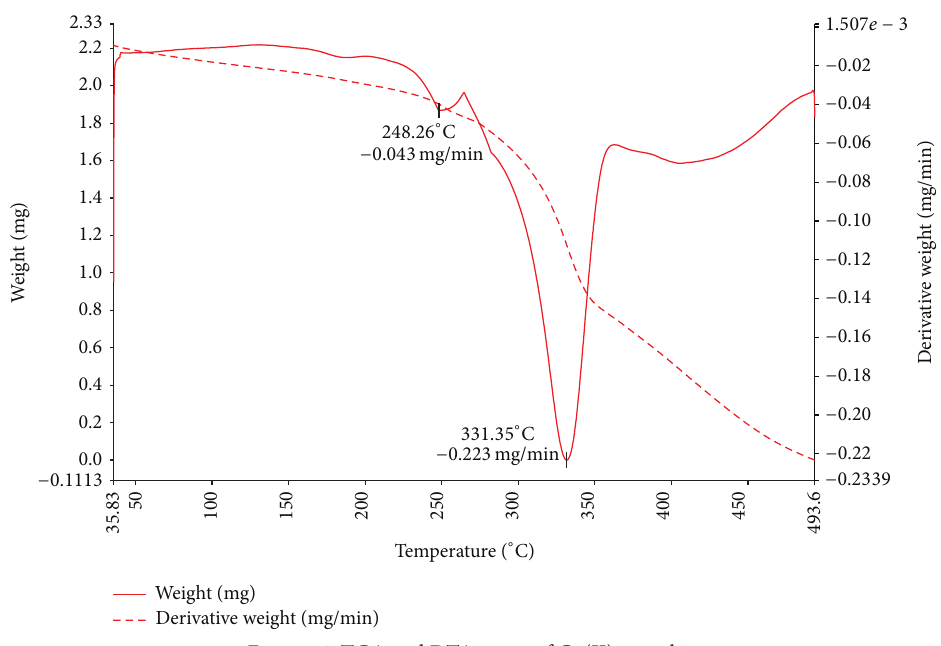
Figure 4: TGA and DTA curve of Cu(II) complex.